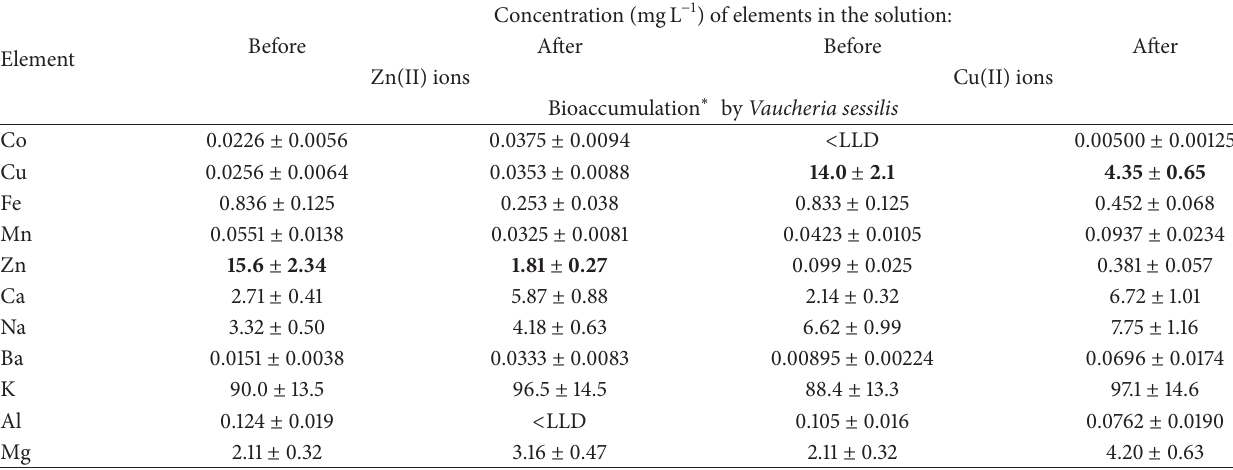
Table 1: The concentration of elements in the solution before and after bioaccumulation of Zn(II) and Cu(II) ions by Vaucheria sessilis . Concentration (mgL − 1 ) of elements in the solution: Before After Before After Element Zn(II) ions Cu(II) ions Bioaccumulation ∗ by Vaucheria sessilis Co 0.0226 ± 0.0056 0.0375 ± 0.0094 < LLD 0.00500 ± 0.00125 0.0353 ± 0.0088 14.0 ± 2.1 4.35 ± 0.65